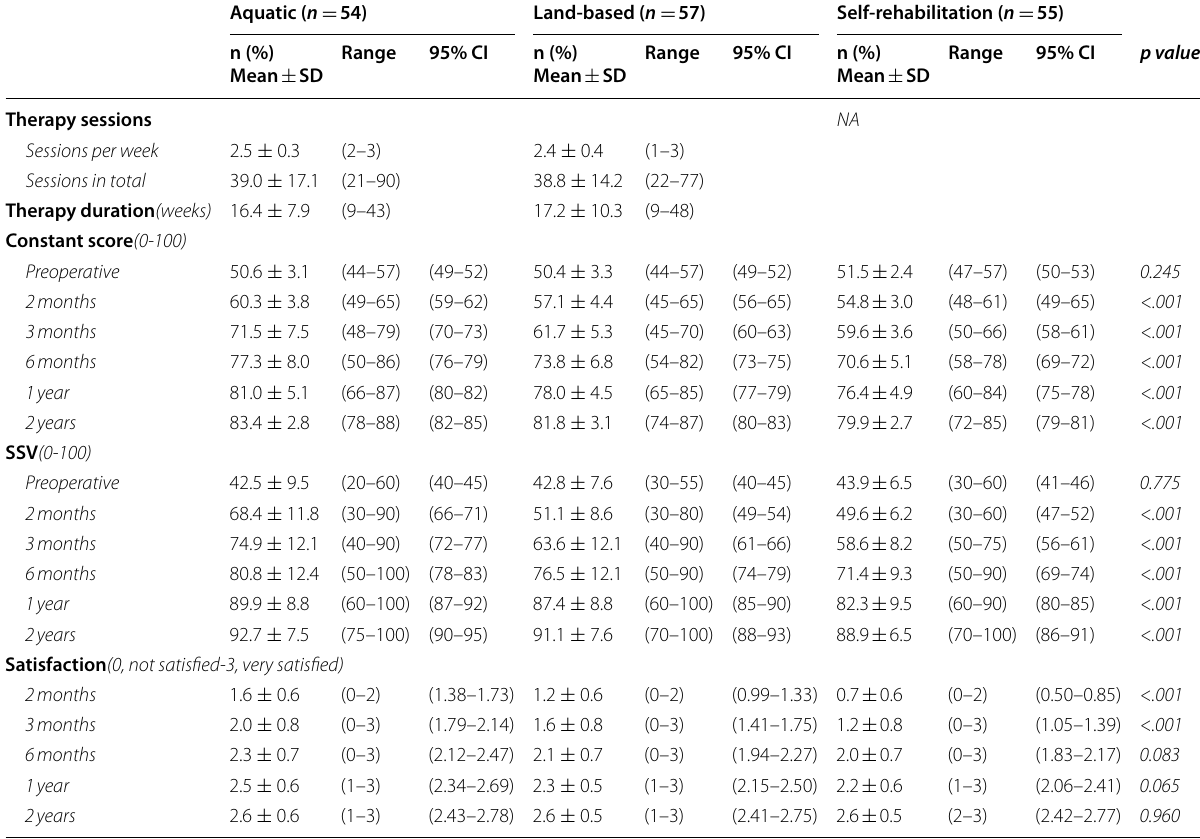
Table 3 Postoperative data and clinical scores